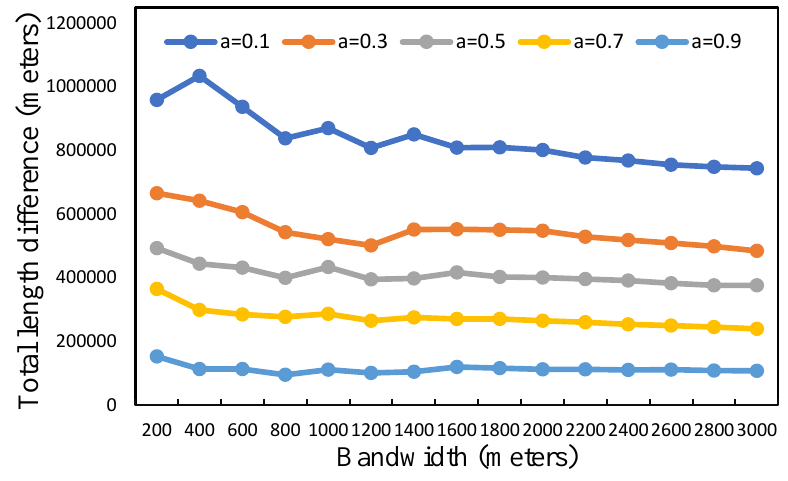
Figure 6. The di ff erence between the service areas delimited by our method and the general Voronoi method with di ff erent bandwidths: a is the parameter for comparing geometric distance to fire risk in the cost measure of street segment.